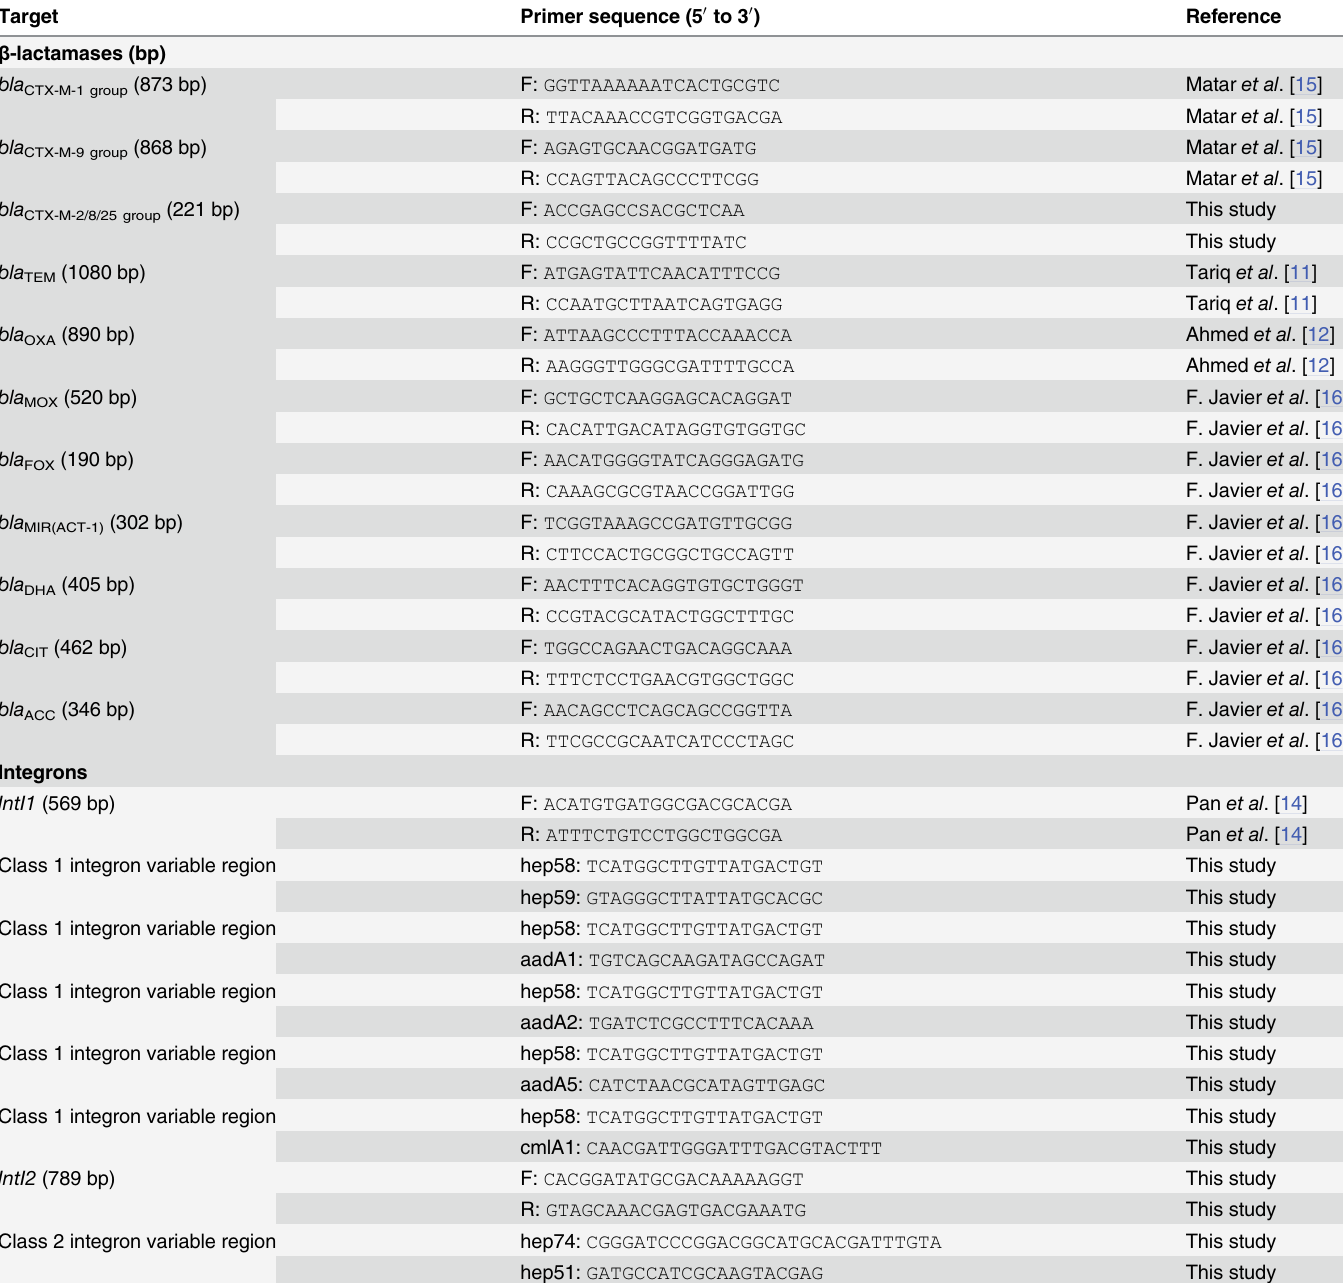
Table 1. Primers for detection of antibiotic-resistance determinants and